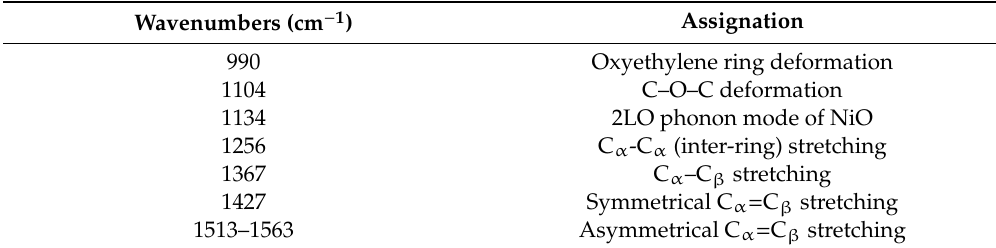
Table 1. The vibration modes of PEDOT in the Raman spectra